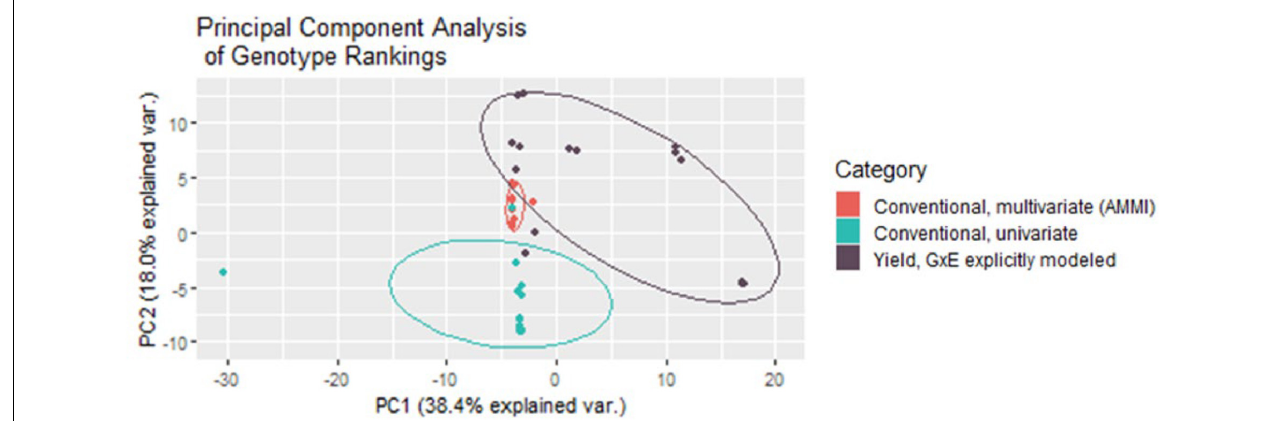
FIGURE 6 | Multivariate conventional yield stability rankings group much tighter and closer to rankings generated from the BLUPs from fitting GxE interaction effects as random in the mixed model for